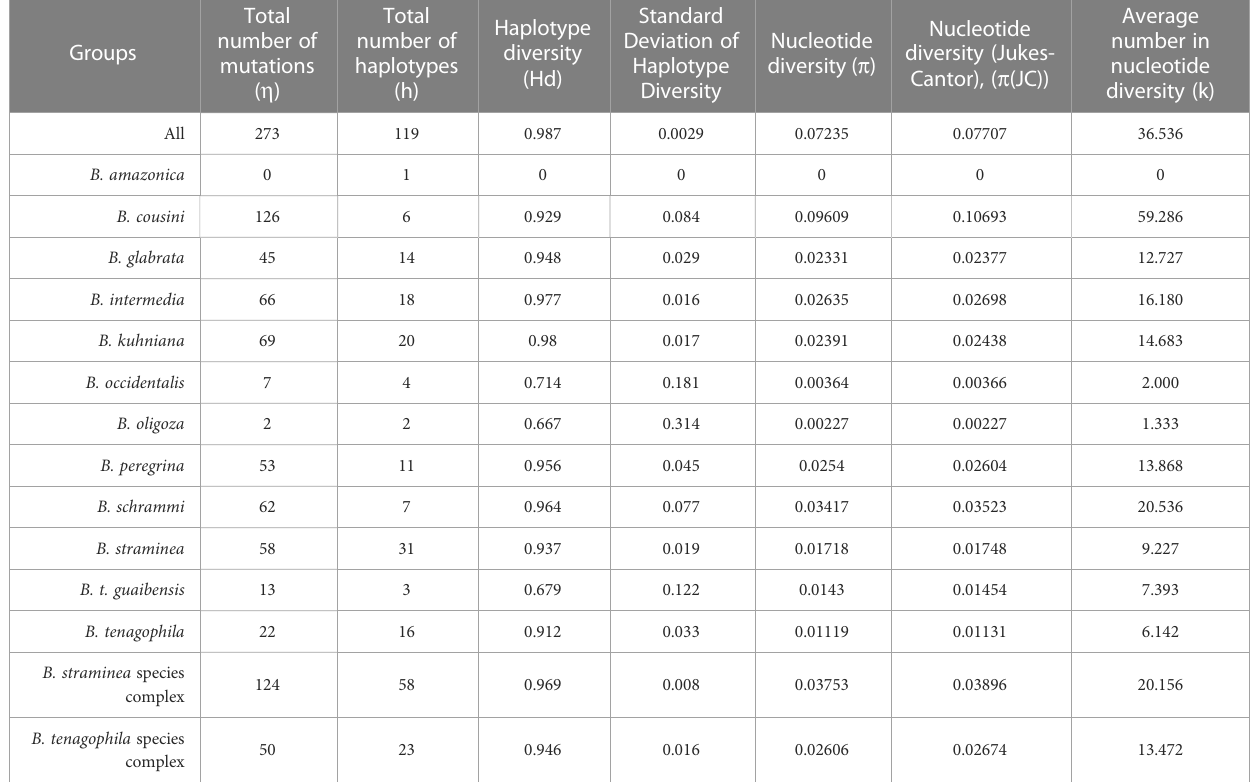
TABLE 2 Genetic polymorphism indices in partial sequences of the COI gene from populations of Biomphalaria .